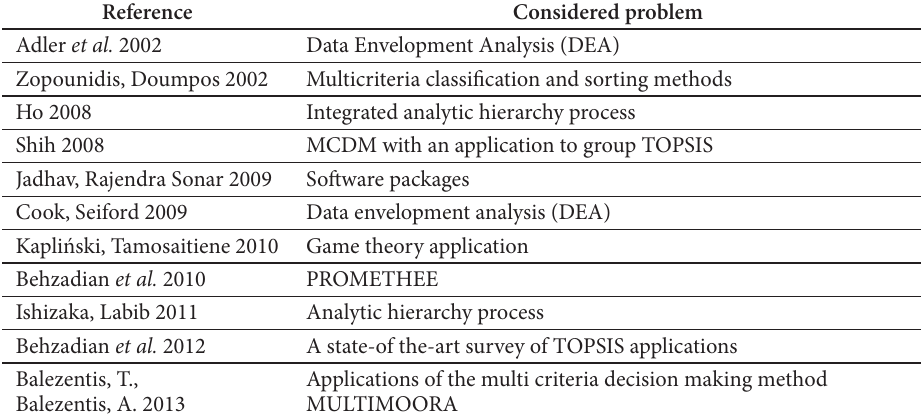
Table 4. Overview on application of different MCDM